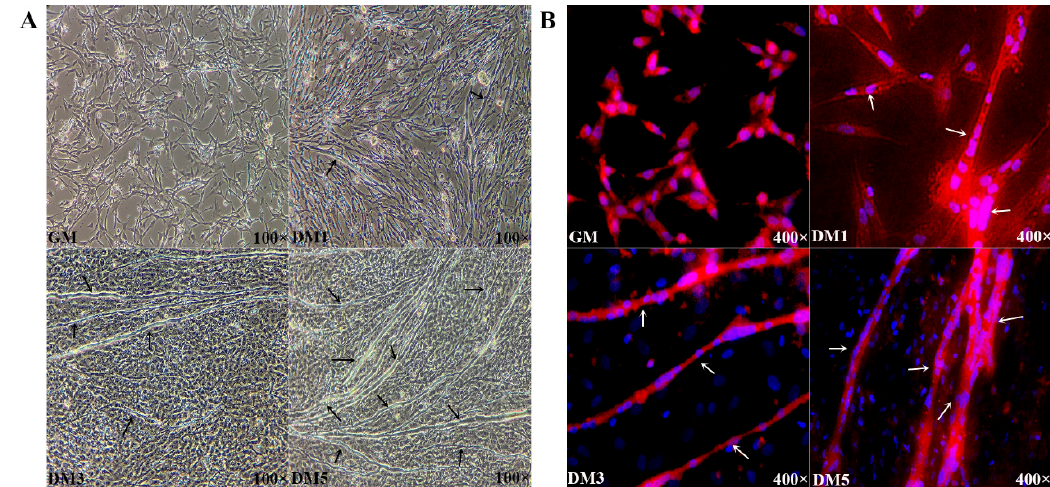
Figure 1. ( A ) Microscopic images of chicken primary myoblasts cultured in growth medium (GM) (100% confluence) or in differentiation medium (DM) for 24 h (DM1), 72 h (DM3) and 120 h (DM5). Black arrows represent myotubes; and ( B ) cells were fixed and immunostained for desmin in GM and DM. Nuclei were stained with DAPI. White arrows represent fused myotubes. Cells at different developmental stages were collected for use in the following procedures. The red and blue color represented cytoplasm and cell nucleus, respectively.